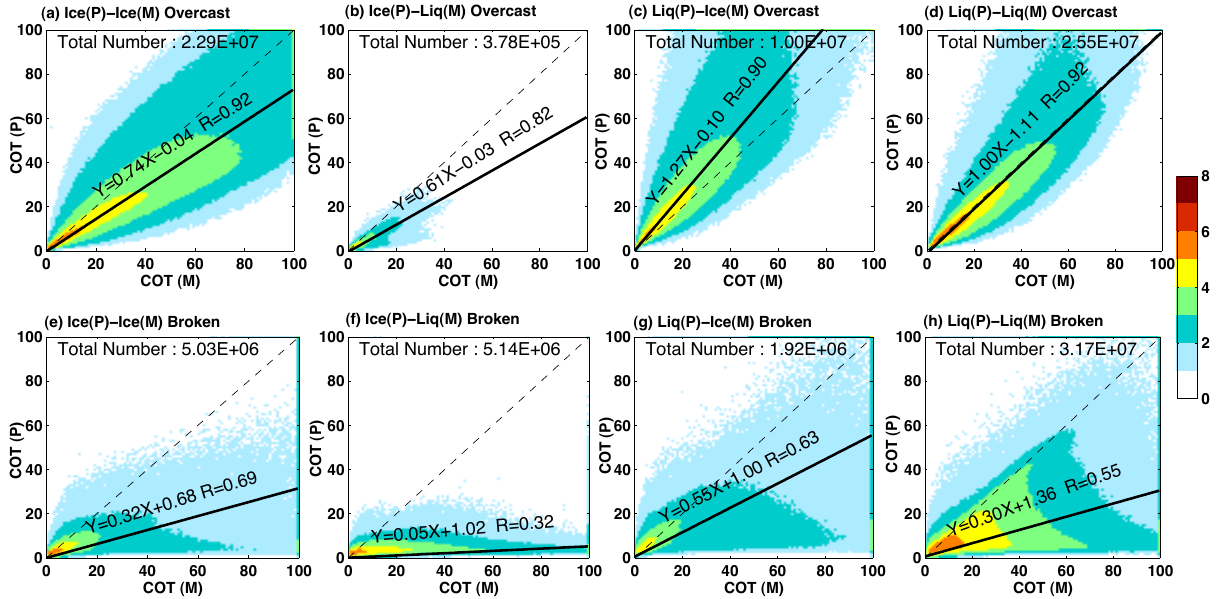
Fig. 4. Two-dimensional histograms of POLDER and MODIS COT for 4 different classes of overcast and broken clouds over ocean. They are separated by cloud combined phase. Color scale on the right represents the logarithm of the pixel number. Dashed lines are the one-to- one function lines meaning the POLDER COT equal to the MODIS one. Solid lines are the computed linear regression functions between POLDER (y-axis) and MODIS (x-axis) COT, with slopes and correlation coefficients ( R ) labeled above the solid